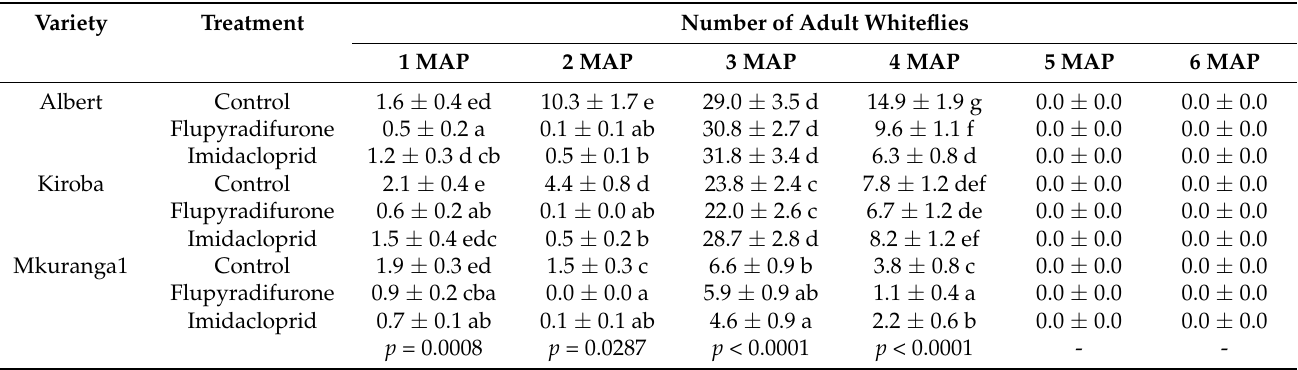
Table 2. Whitefly abundance for Vuli 2017 in the foliar application trial (Means ± SE) Z . Variety